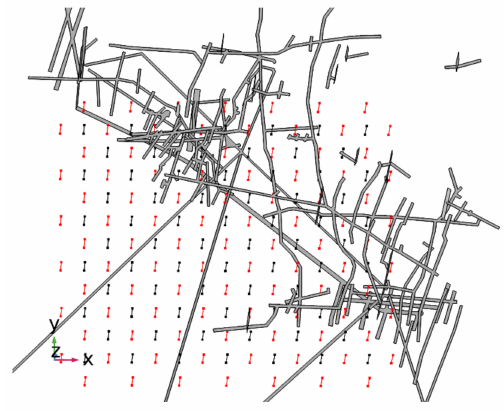
Figure 23. Well field design in an example scenario; red colour identifies the injection wells.